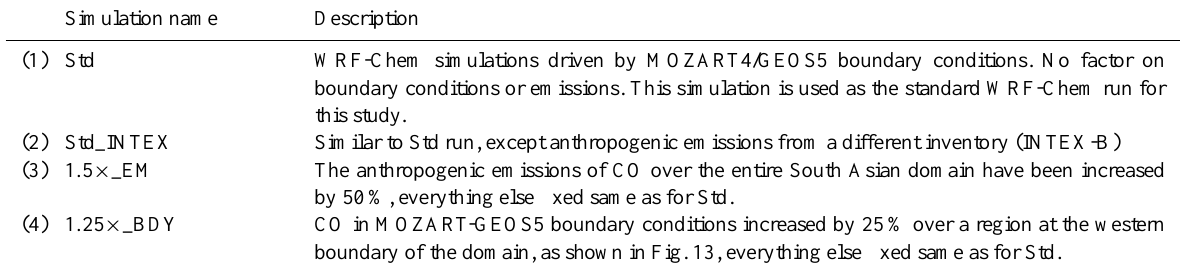
Table 2. Description of WRF-Chem simulations performed for this